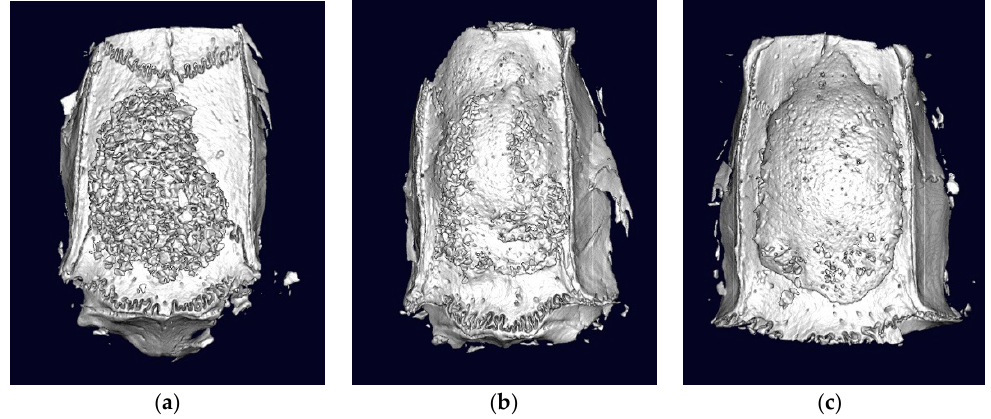
Figure 2. The 3D reconstruction images of microcomputed tomography ( µ -CT) in the ( a ) control, ( b ) ABB/low bone morphogenetic protein (BMP), and ( c ) ABB/high BMP group at 6 weeks after operation.